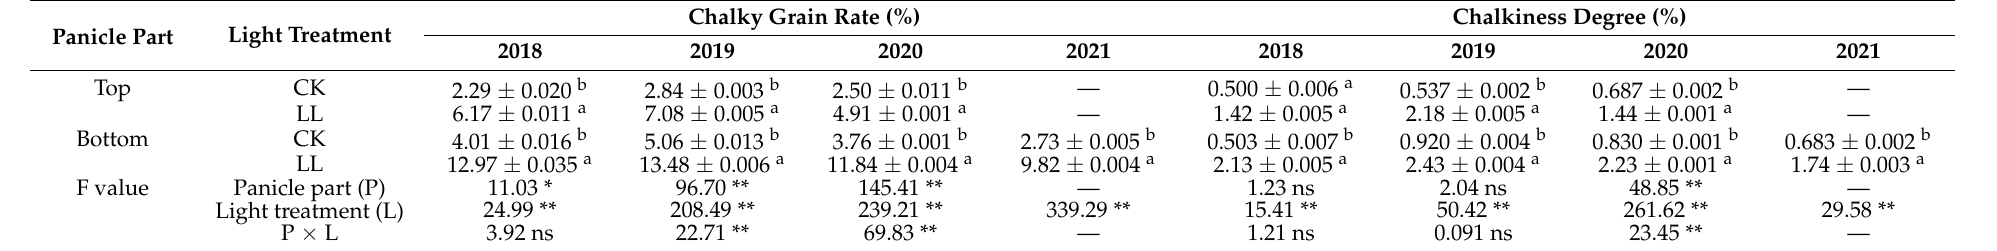
Table 1. Effect of low light stress on chalky grain rate at different panicle